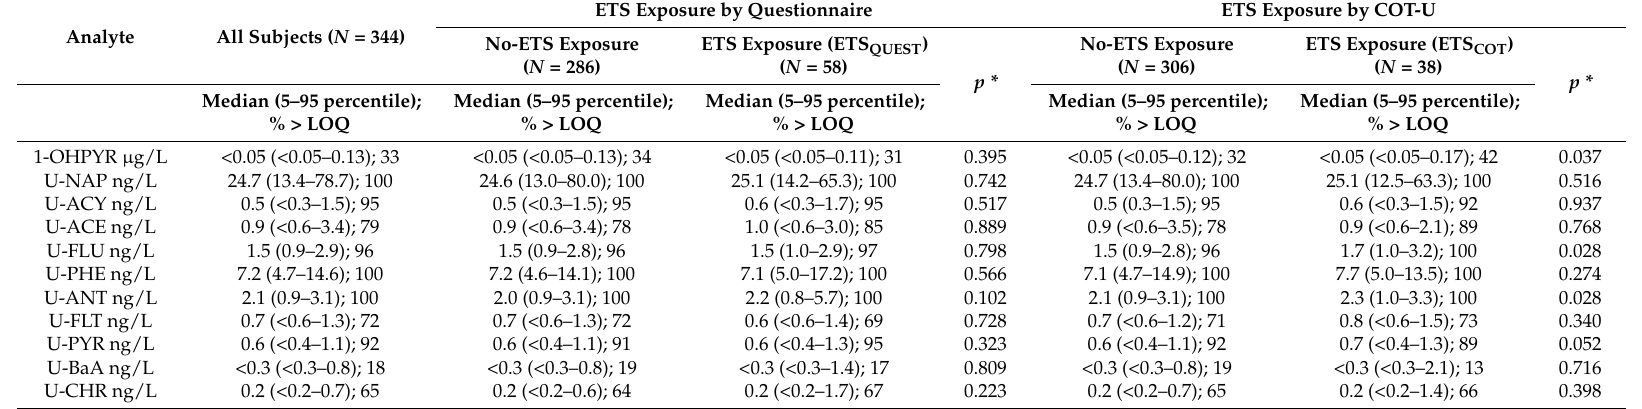
Table 2. Urinary 1-OHPYR and PAH levels in subjects stratified by ETS exposure based on COT-U excretion (ETS COT : COT-U > 1.78 µ g/L) and on self-classification by questionnaire (ETS QUEST